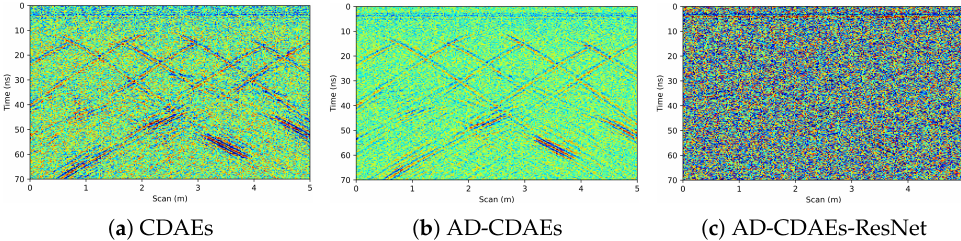
Figure 11. Noise attenuation residual for the GPR profile of the tunnel